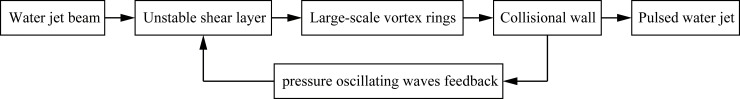
The process of the self-excited oscillation pulsed water jet formation.